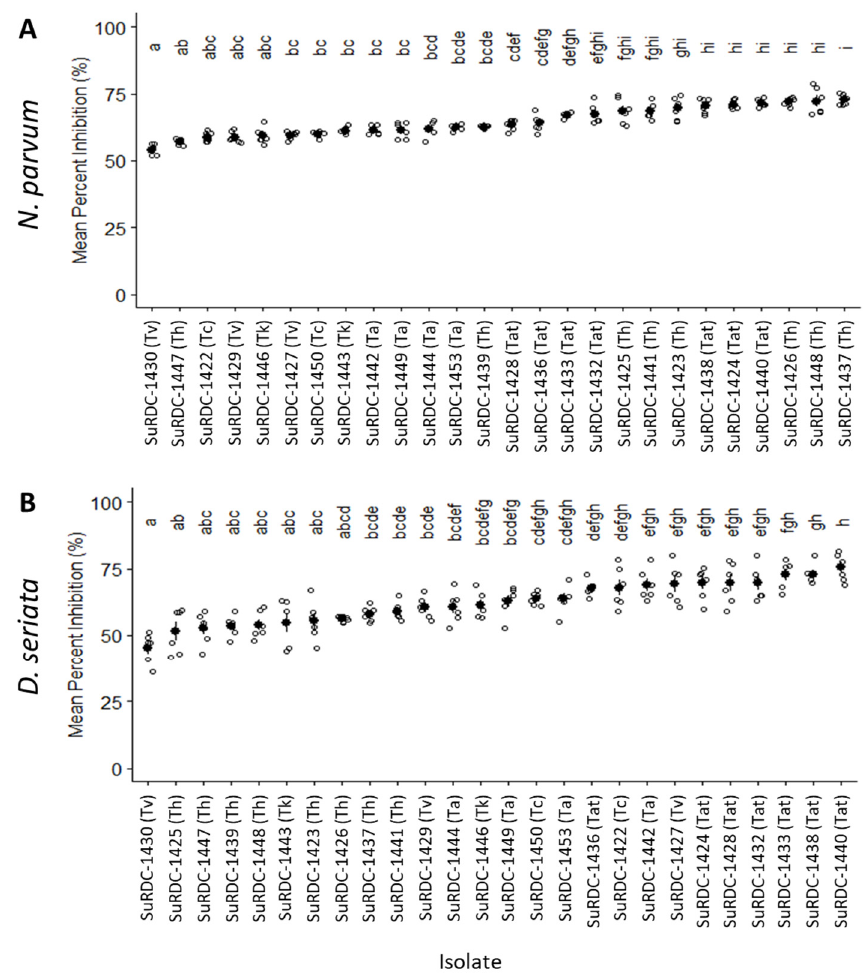
Figure 5. Mean percent radial growth inhibition (MPRGI) of Trichoderma isolates from BC against BD pathogens Neofusicoccum parvum SuRDC-1089 ( A ) and Diplodia seriata SuRDC-1064 ( B ) measured after 5 d. White dots represent data from experiment 1 and repeated experiment 2. Solid black dots represent the MPRGI for each isolate calculated from six replicates. Bars represent standard errors of the means. Columns accompanied by the same letter were determined not to be statistically different by the Tukey–Kramer Honest Significant Difference post-hoc test ( p = 0.05). Ta, T. asperelloides ;